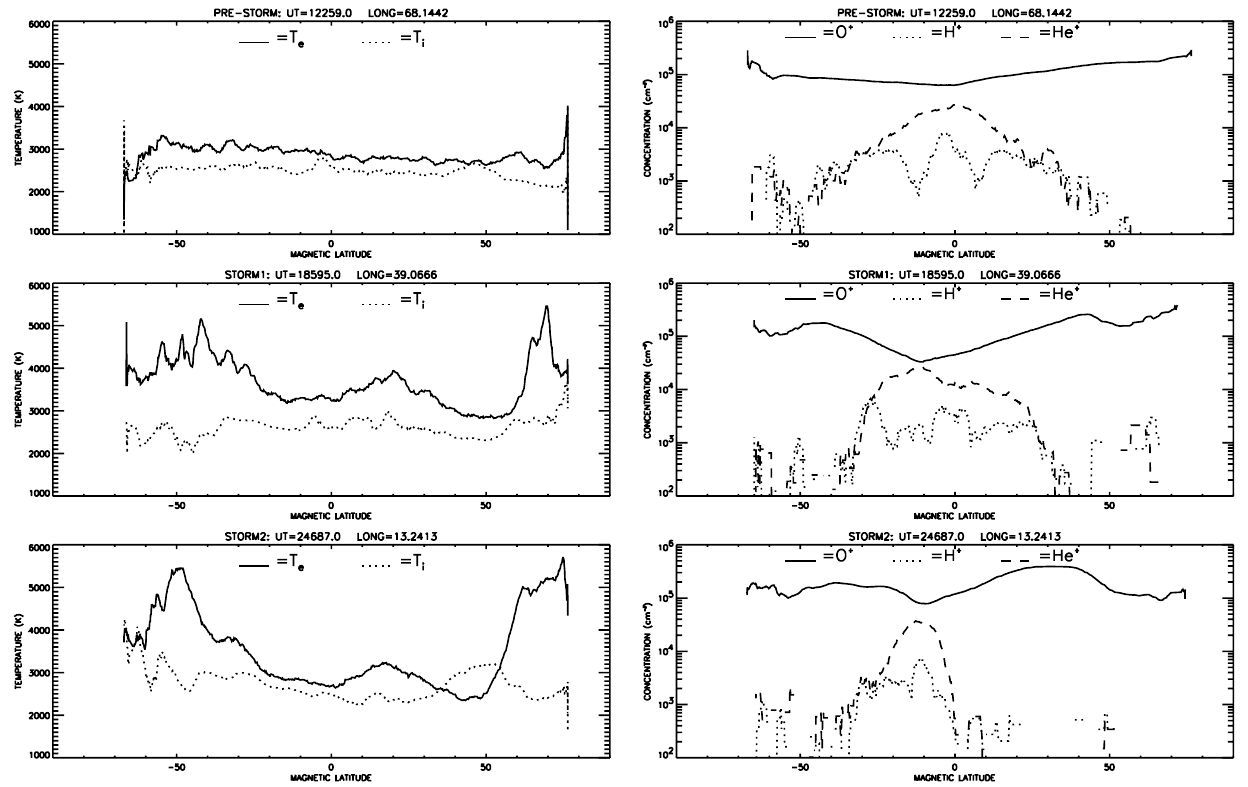
Fig. 2. Observations of the ion and electron temperatures, and the O + , H + and He + ion concentrations, made close to 09:00MLT by the RPA and LP instruments on board the DMSP F10 satellite, on three orbits surrounding the storm commencement of 24 March 1991. It should be noted that during parts of the orbits the concentration of H + and He + fell below the level of detectability. The spacecraft longitude (in degrees) and UT (in seconds) are given for the equatorward crossing of each